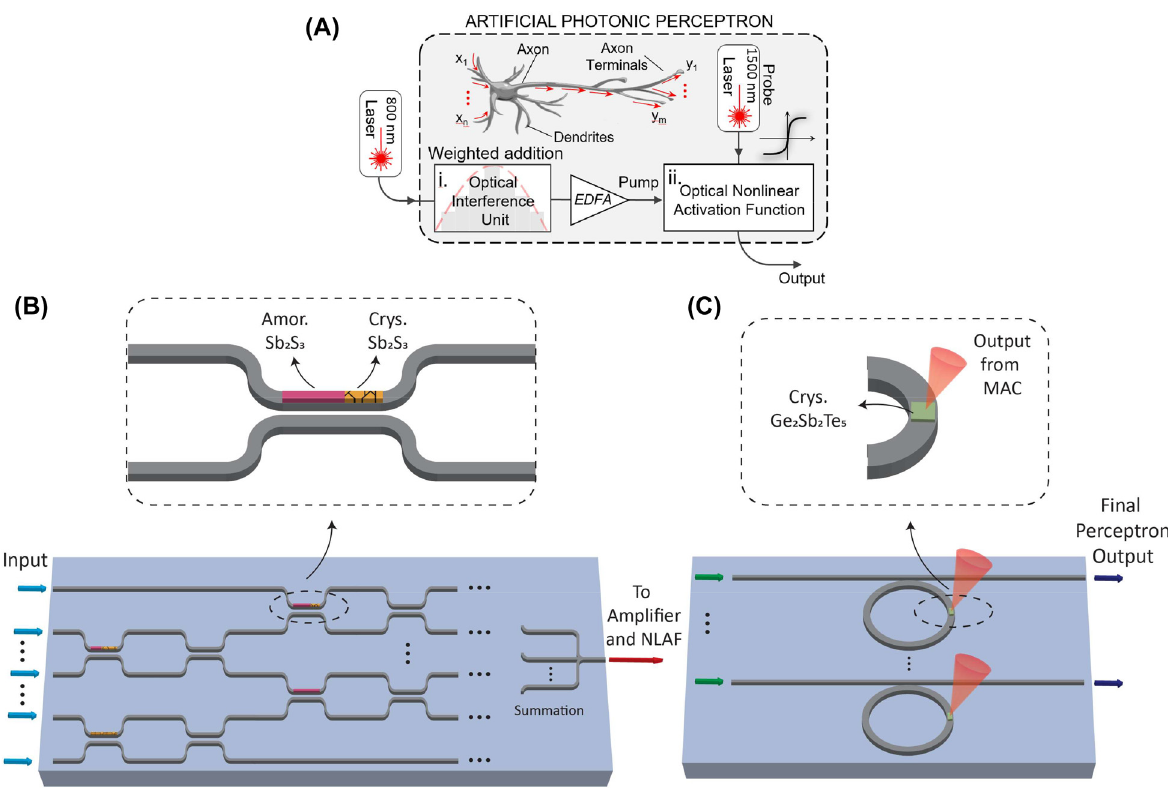
Figure 1: All-chalcogenide optical perceptron model. (A) Schematic diagram of the perceptron. (B) P 3 A consisting of a network of reprogrammable MZI weights. Recon fi gurability is introduced by the Sb 2 S 3 - tuned directional coupler arm. (C) Ge 2 Sb 2 Te 5 -tuned MRR